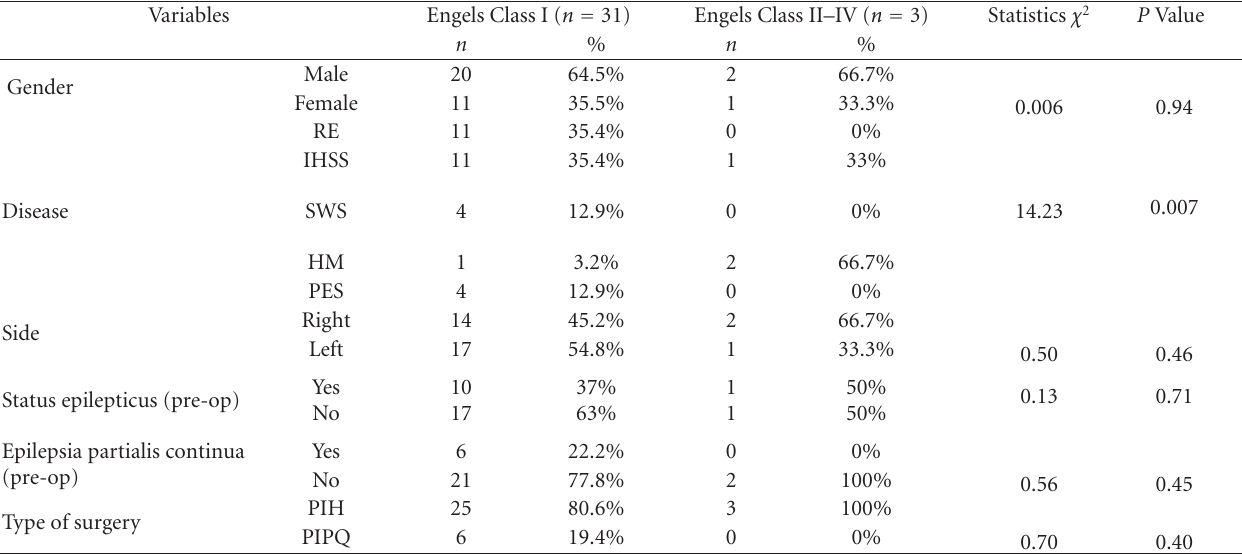
Table 3: Presurgery predictors of gender, disease, and type of surgery on postsurgery seizure outcome.